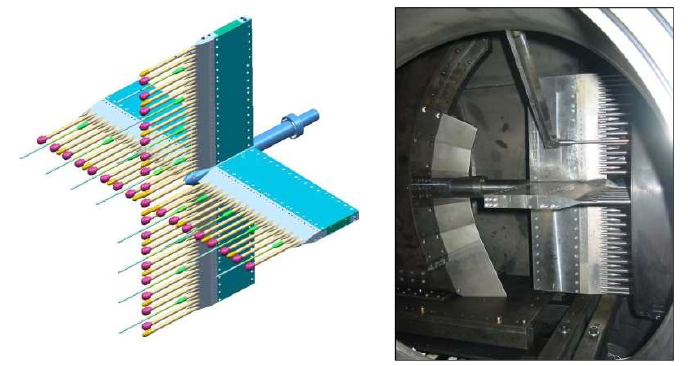
Figure 8: HEG calibration rake – design drawing (left) and rake installed in the test section